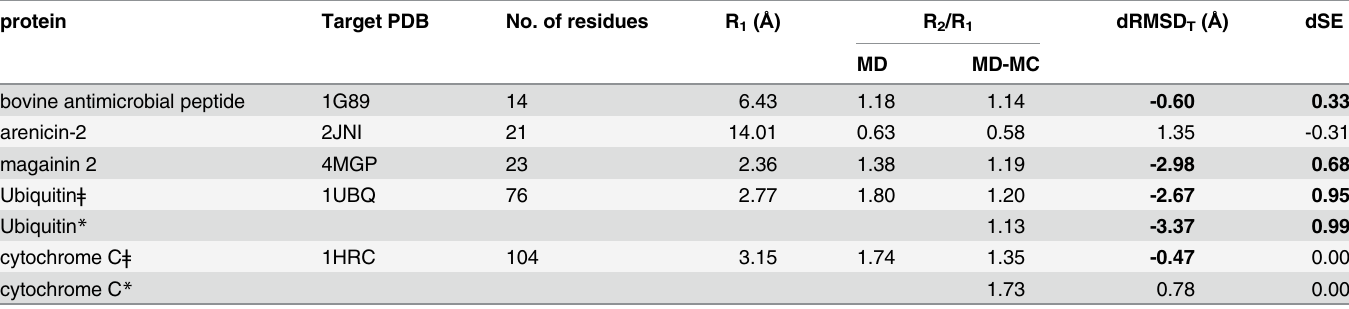
Table 4. Testing results of the 5 real proteins. R 1 , R 2 /R 1 , dRMSD T and dSE are the mean value calculated based on 3 trajectories in the backward MD and MD-MC simulations for three peptides, while they are from single trajectory for ubiquitin and cytochrome C. The representations of R 1 , R 2 , dSE are pre- sented in Table 2. dRMSD T represents the reduction of RMSD T for hybrid MD-MC simulations as comparing to the parallel MD simulations. The hybrid MD-MC simulations with improvement in either SE or RMSD are bolded.